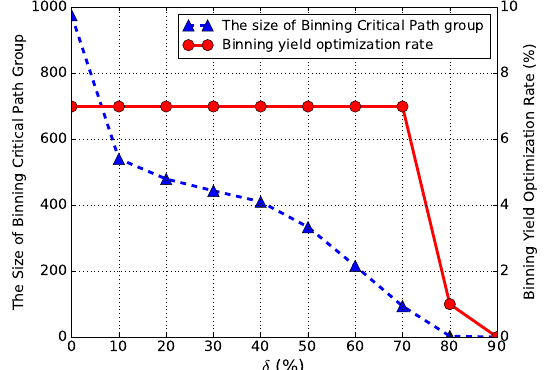
Figure 12. The impact of Binning Critical Path selection criteria ( δ ) on the size of Binning Critical Path group, as well as the Yield Optimization Rate , considering 10% L, Nmos: vth0 = 17% toxref = 10%; Pmos: vth0 = 18% toxref = 10% process variations for